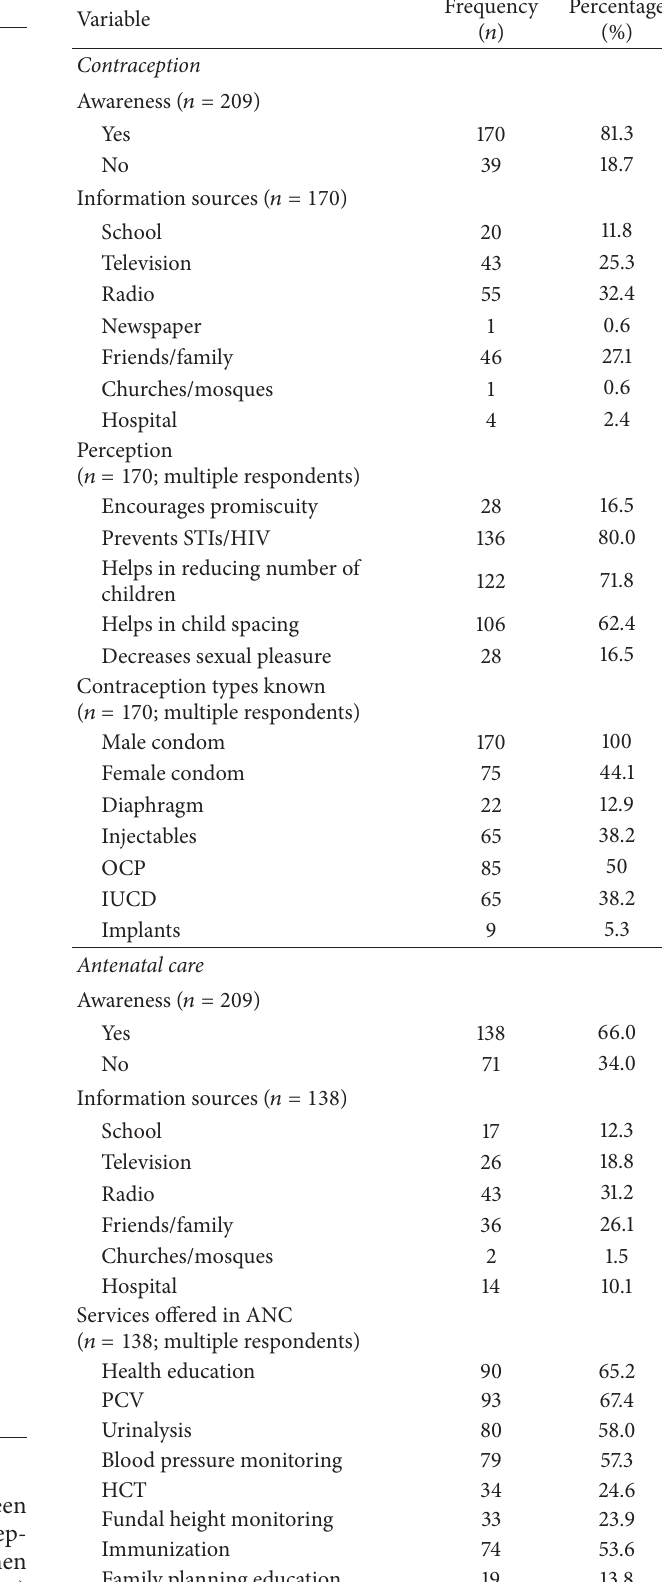
Table 3: Knowledge about HIV/AIDS. Table 4: Knowledge of respondents about contraception and Ante- natal